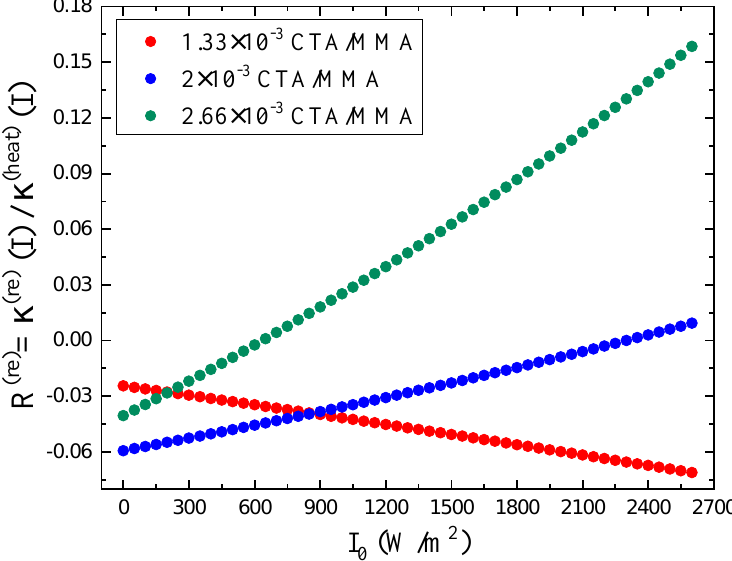
Figure 20. A plot of the ratio of molecular reorientation to heating along the sample’s axis when pumped with 488-nm light for three different CTA